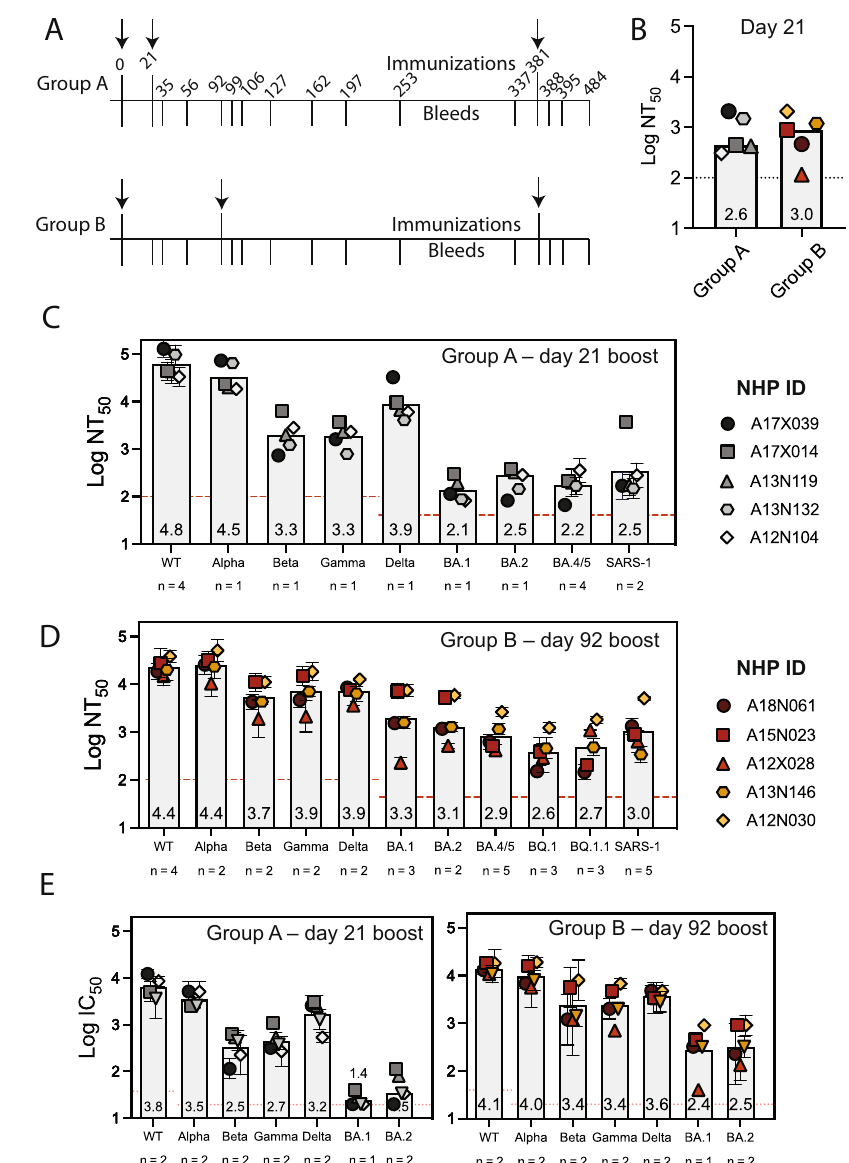
Fig. 3 | DCFHP-alum immunized NHPs elicit cross-reactive neutralizing responses. A Immunization scheme for NHPs immunized in either group A or group B with a 50 µ g dose of DCFHP formulated with 750 µ g alum (SI Table 2). Arrows indicate daysofimmunization. B Pseudoviralneutralization (plotted as the log of the neutralizing titer (reciprocal serum dilution)) of Wuhan-1 SARS-CoV-2 from NHP serum obtained 21 days following initial immunization are similar between groups A and B. C Cross-reactive pseudoviral neutralization by serum from NHPs isolated 14 days post boost. Means and standard deviations for